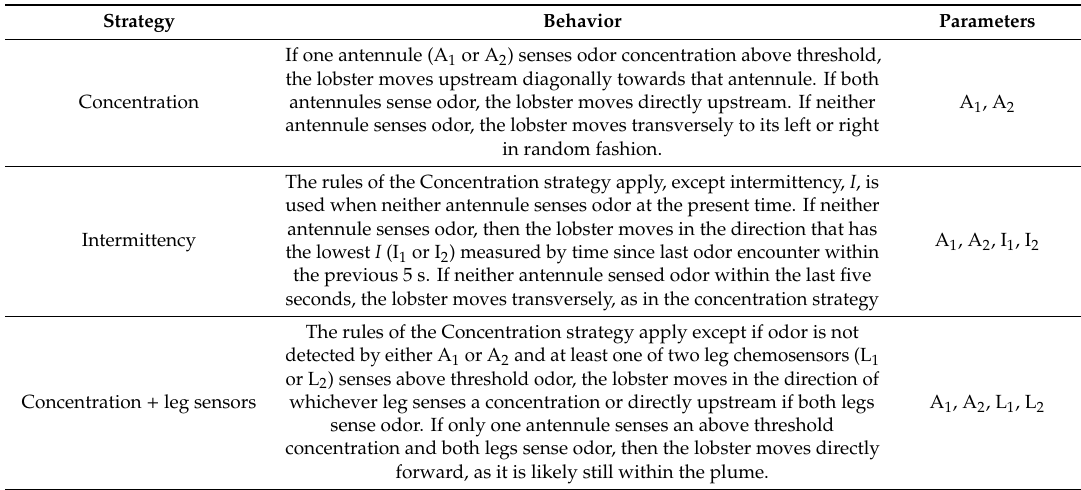
Table 2. Summary of the search strategies